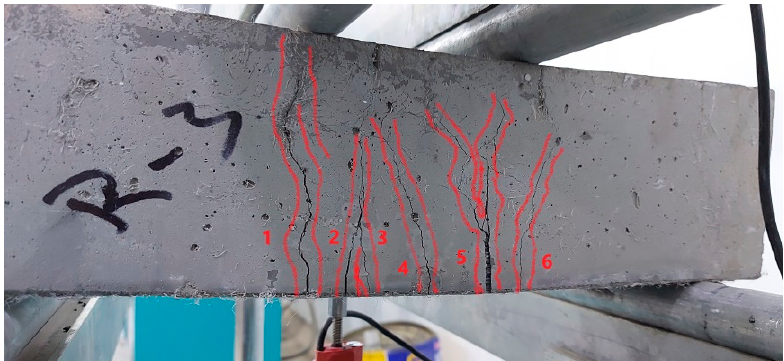
Figure 5. Multi-cracking failure of tested prisms.